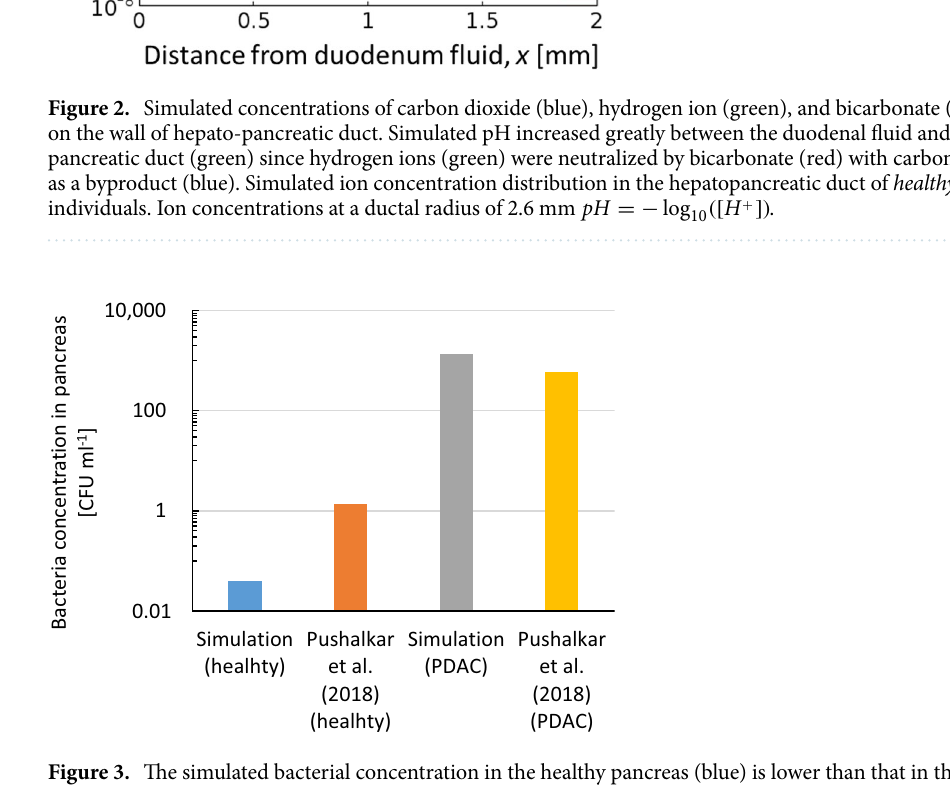
Figure 3. The simulated bacterial concentration in the healthy pancreas (blue) is lower than that in the literature (orange), but simulated bacterial amount in pancreas at 3.2 CFU agrees reasonably we the literature that 15% of healthy pancreas contained detectable bacteria 10 . Simulated one in the pancreas with tumors (gray) agrees reasonably well with the literature 12 (yellow). The literature value was calculated using the DNA weight of E. coli at 17 fg/cell. PDAC: pancreatic ductal adenocarcinoma.